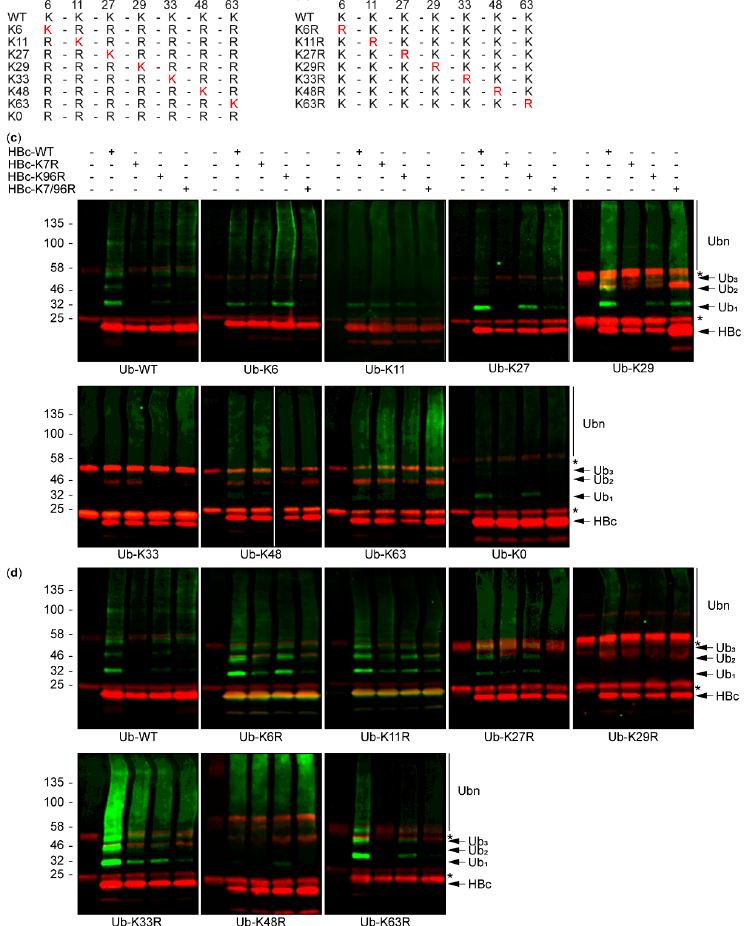
Figure 5. HBc variants are ubiquitinated at different levels using different ubiquitin variants. ( a ) Single K mutants and ( b ) K-to-R mutants used as ubiquitin variants; ( c , d ) Western blots of immunoprecipitated complexes of Huh 7 cells transiently co-transfected with one HA-tagged single K ( c ) or K-to-R ubiquitin mutant ( d ) and one FLAG-tagged HBc variant. For ubiquitin detection, the rabbit antibody against the HA-tag was used (IRDye 800CW, green), while for HBc detection, the mouse antibody against the FLAG-tag was used (IRDye 680RD, red). Original figure of Ub-K48 Western blot is included as Figure S3 in the Supplementary Materials. Heavy and light chains of IgG are marked with